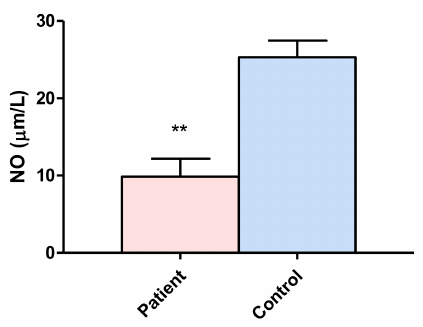
Figure 2. Comparison of nitric oxide (NO) concentrations between patients with drug resistant partial complex seizure and controls. The bars represent the means ± standard errors of the mean. Unpaired t-Student test. ** p ≤